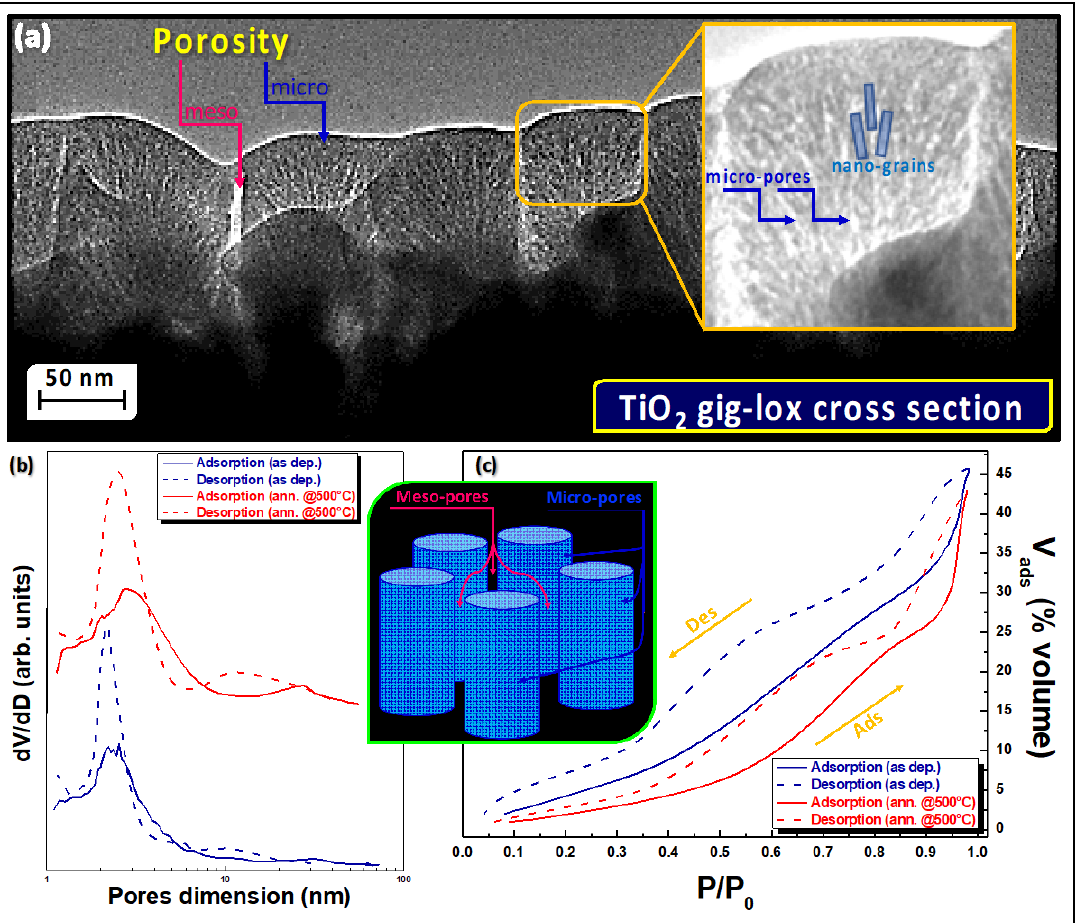
Figure 3. ( a ) TEM cross section of the gig-lox layer showing the material arrangement by nano-grains in a matrix of interconnected micro-pores (zoom in the yellow region). ( b ) Pore size distribution deduced from the Kelvin law for cylindrical interconnected pores for TiO 2 gig-lox in as-deposited and after annealing at 500 °C conditions. ( c ) Volume of adsorbed gas as a function of P/P 0 for TiO 2 gig-lox in as-deposited and after annealing at 500 °C conditions.